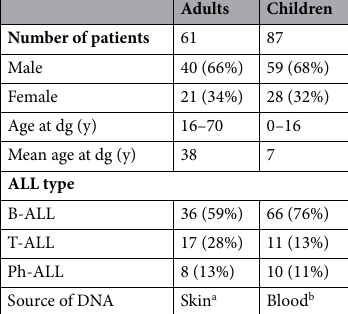
Table 1. Summary of patient characteristics and source of DNA. Dg, diagnosis; y, years; B-ALL, Ph-negative B-ALL; Ph-ALL, Ph-positive B-ALL. a One adult patient’s DNA was extracted from blood, but after recovering from ALL. b See methods for determining the germline/somatic origin of